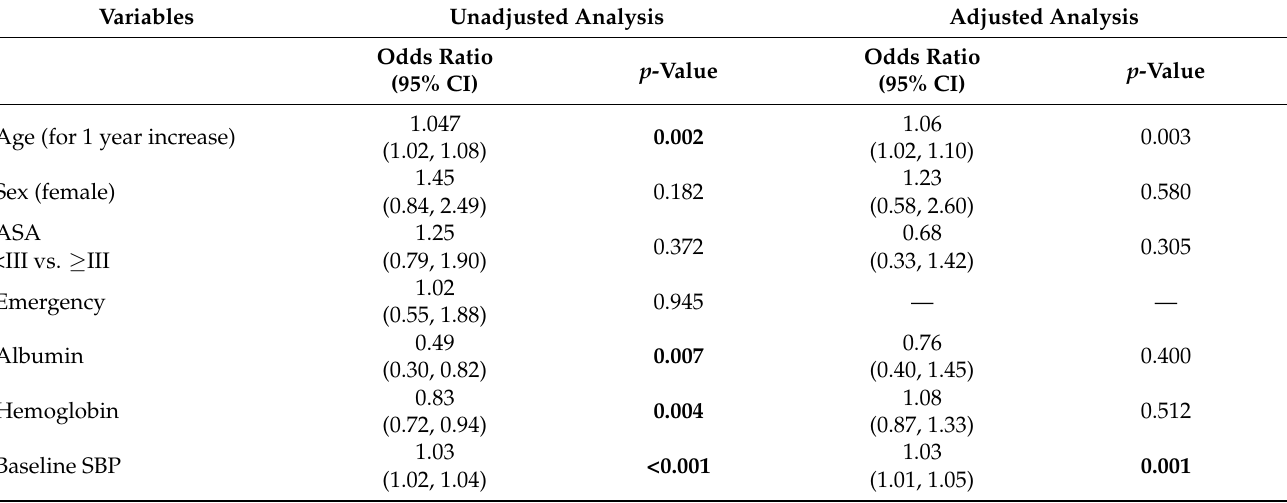
Table 3. Unadjusted and adjusted odds ratios for predicting IOH by binary logistic